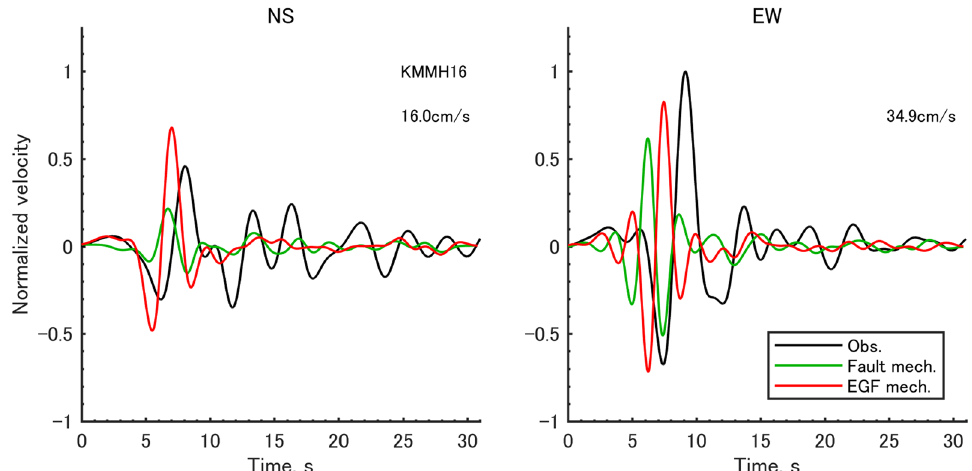
Fig. 2 Comparison of simulated (red and green) and observed (black) waveforms for SMGA model of Somei et al. (2019), for two cases of GFs: Case 1 (green line; source mechanism of GFs adjusted to the main fault) and Case 2 (red line; source mechanism of GFs adjusted to the EGF). Waveforms are normalized to the peak amplitude of observed